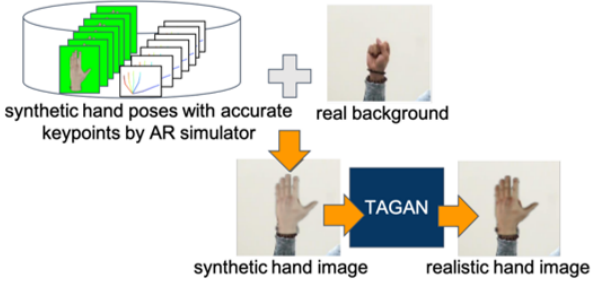
Figure 4. Overview of the TAGAN method for realistic hand image synthesis [33]. Synthetic pose by an AR simulator is blended with real background to yield a synthetic hand image, which is then fed to the proposed TAGAN to produce a more realistic hand image. Originally used in [33].